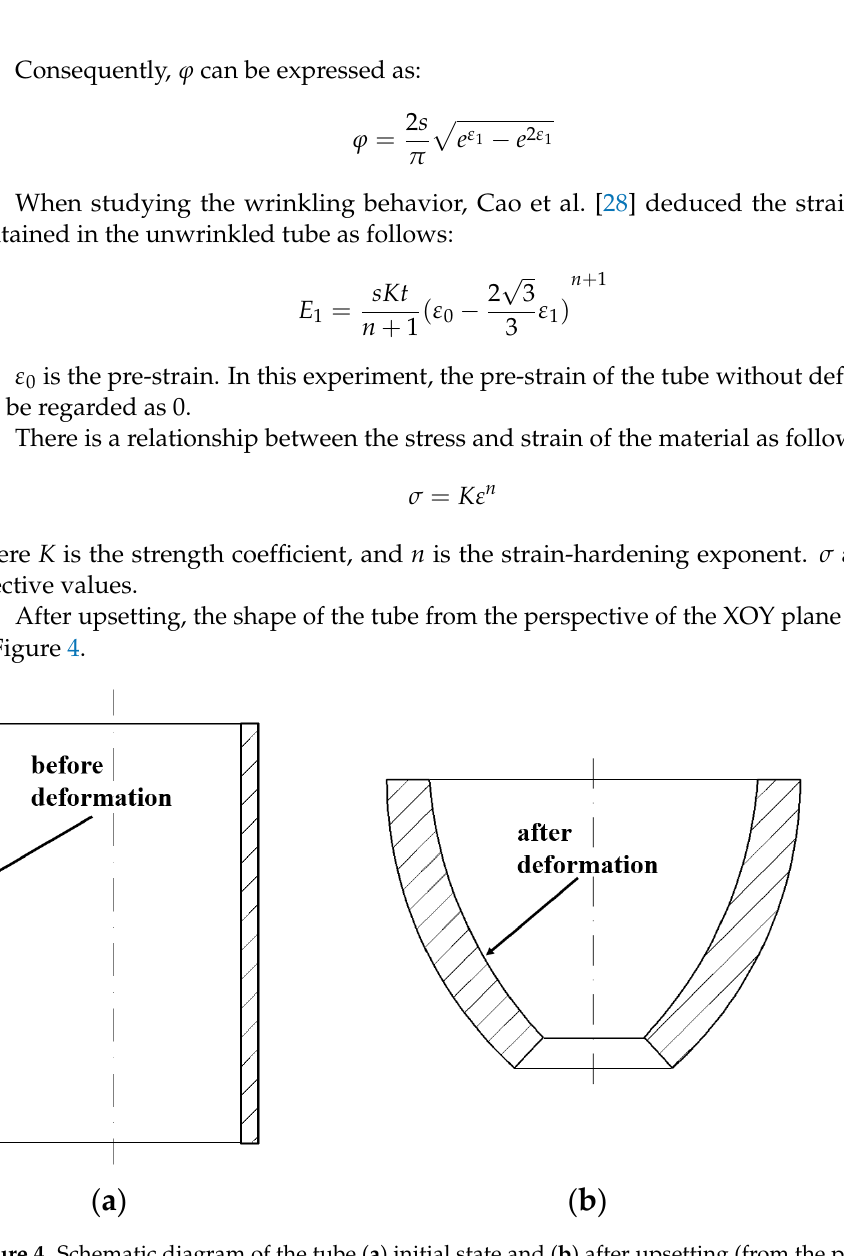
Figure 4. Schematic diagram of the tube ( a ) initial state and ( b ) after upsetting (from the perspective of the XOY plane).